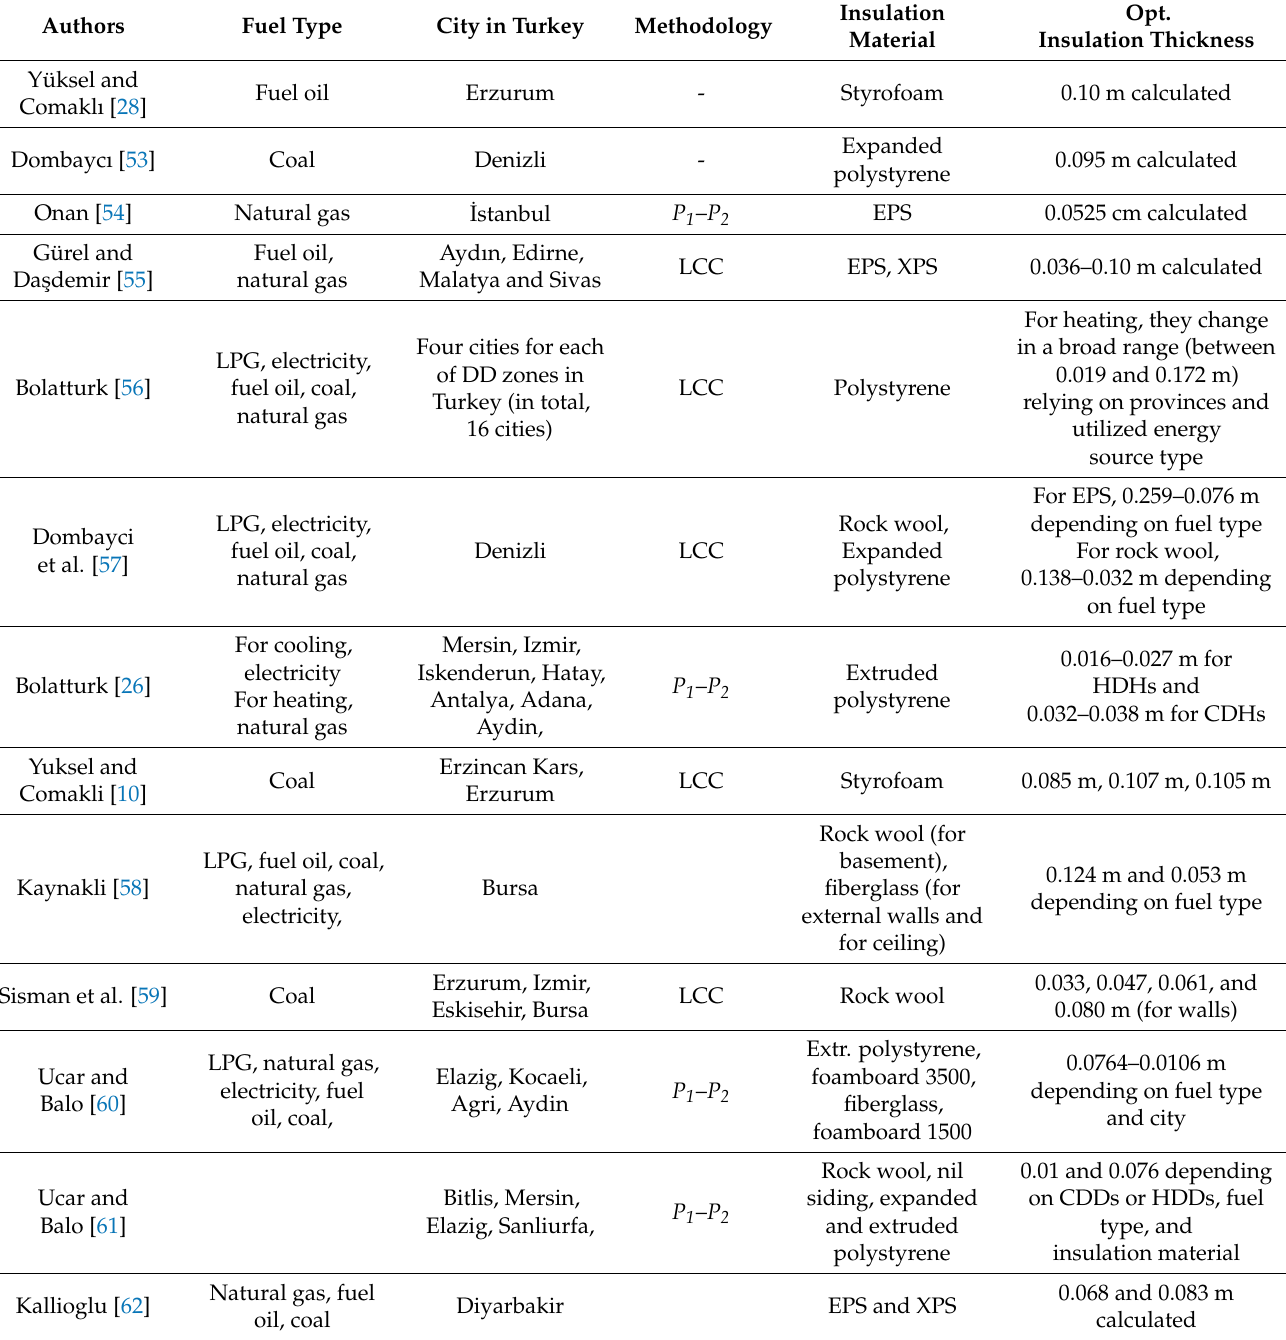
Table 1. A brief summary of studies in Turkey pertaining to optimum insulation